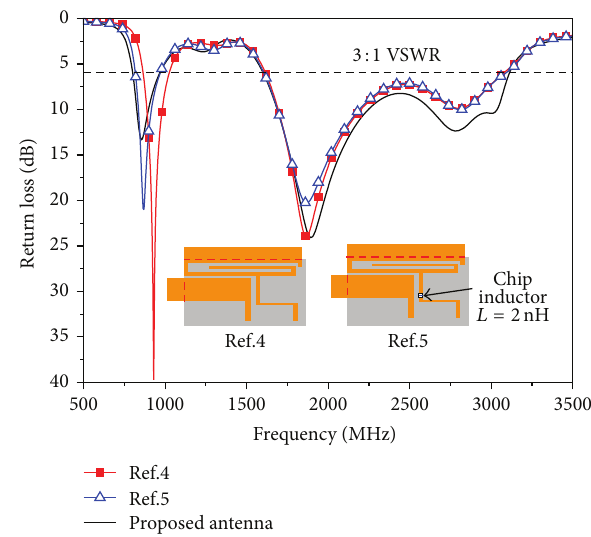
Figure 5: Comparison of simulated return loss for the proposed antenna, reference antenna with simple shorting strip (Ref.4), and reference antenna with a chip inductor instead of the distributed inductance DE section (Ref.5).